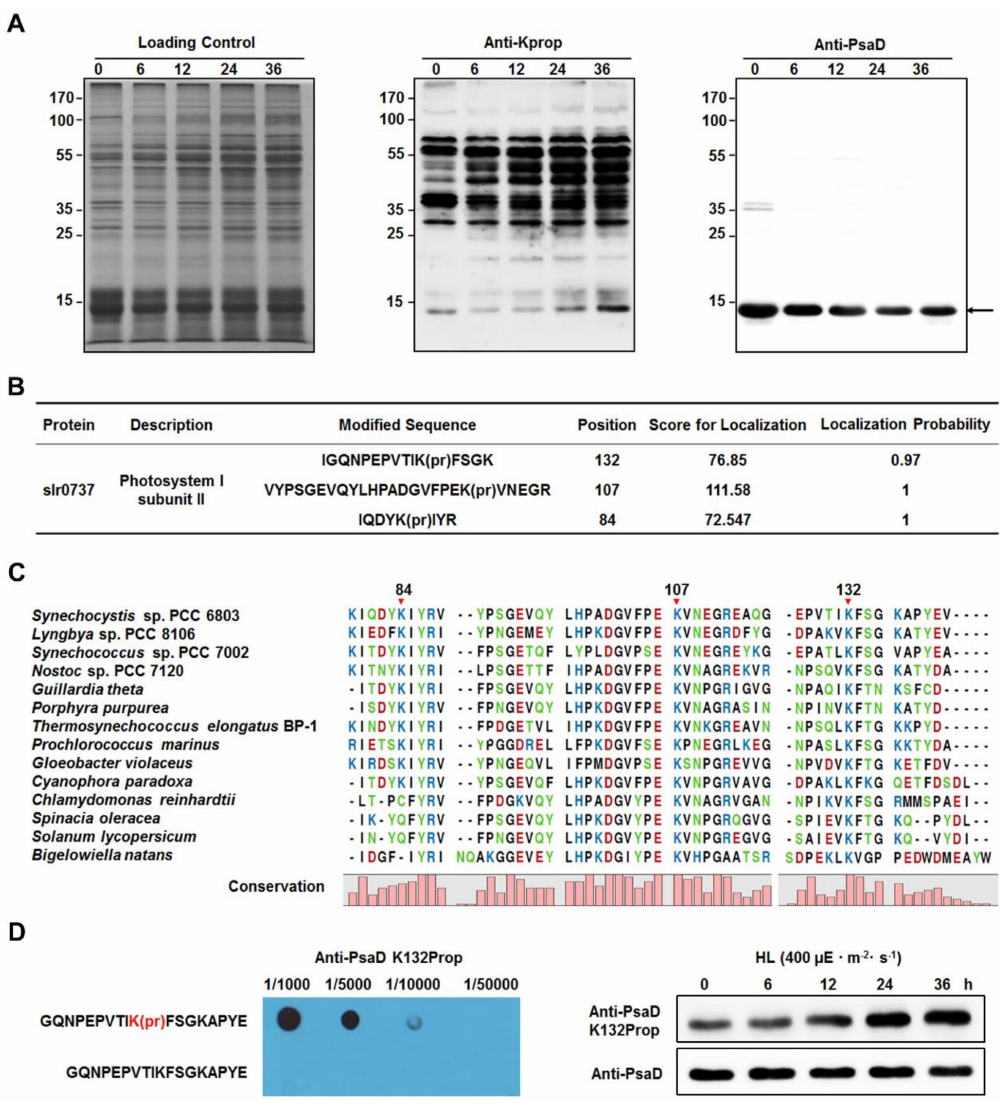
Figure 6. Identification of lysine propionylation in subunit II of photosystem I (PsaD). ( A ) Immunoblotting analysis of propionylation level of proteins from Synechocystis after exposure to high light intensity for 0, 6, 12, 24, and 36 h. Coomassie blue staining was used for the loading control and western blotting analysis was performed using anti-propionyllysine antibody and anti-PsaD antibody. ( B ) List of identified propionylation sites of PsaD. ( C ) Conservation analysis of PsaD from different species (cyanobacteria, algae, and plants). The conserved propionylation sites were marked by the red arrow. ( D ) Immunoblotting analysis of Lys132 propionylation level of PsaD in Synechocystis after exposure to high light intensity for 0, 6, 12, 24, and 36 h. The generated specific anti-Lys132 propionylation antibody was validated by dot blot